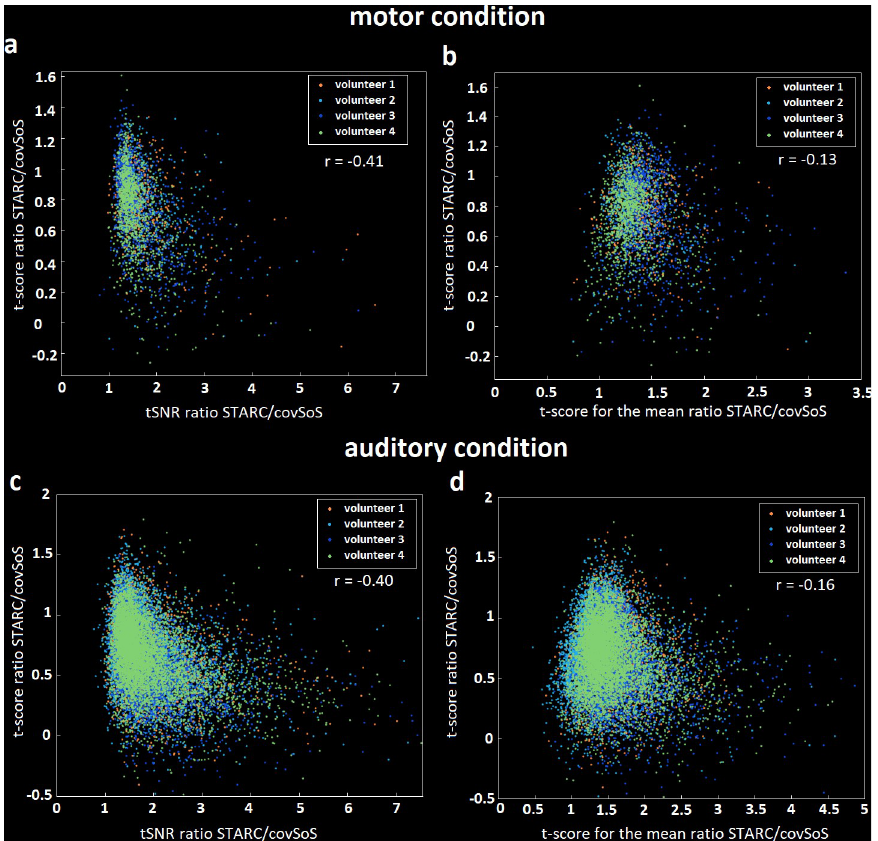
Fig 3. t-score gains versus tSNR or t-score for the mean gains. a—Scatter plot linking the activated voxels, the tSNR gain with STARC to its t-score gain for motor contrast. b–Scatter plot linking the t-score for the mean gain with STARC to its t-score gain for motor contrast. c–Same plot than a but with auditory contrast. d–Same plot than b but with auditory contrast. Each point corresponds to an activated voxel (p < 0.001) according to the covSoS combination maps. In general, an increase of tSNR did not yield a better